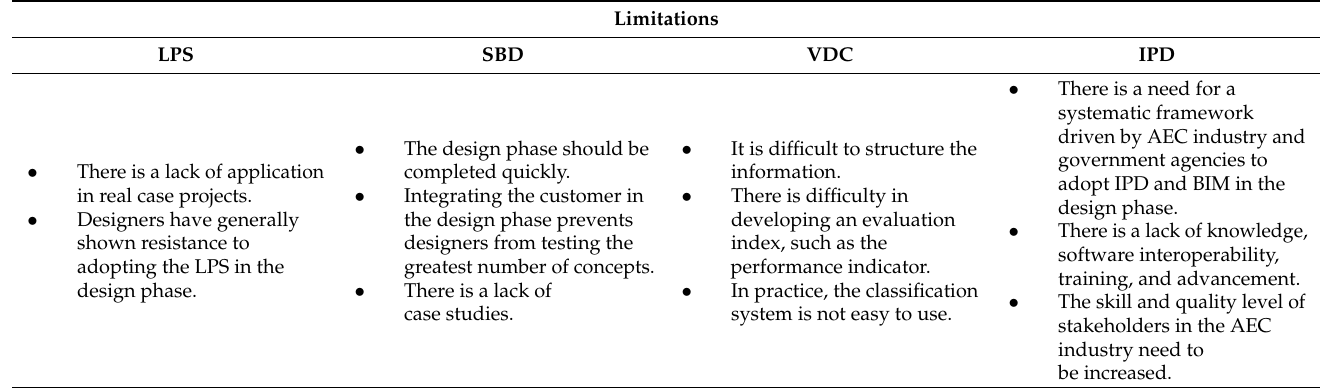
Table 6. Limitations of applying these techniques with BIM during the design